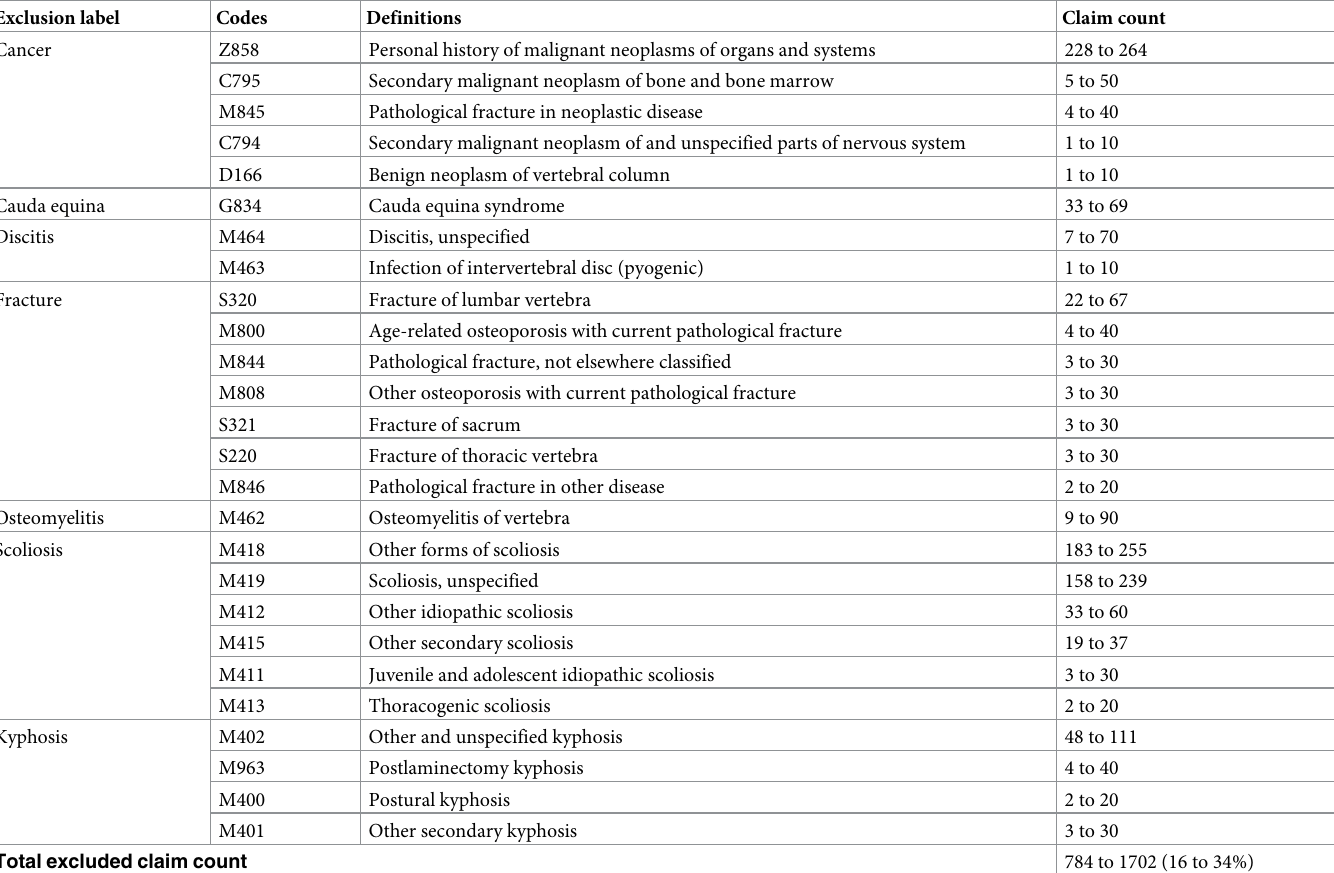
Table 5. Preliminary exclusion criteria for inpatient fusion of lumbar vertebral joint (ICD-10 codes 0SG0-x). Exclusion